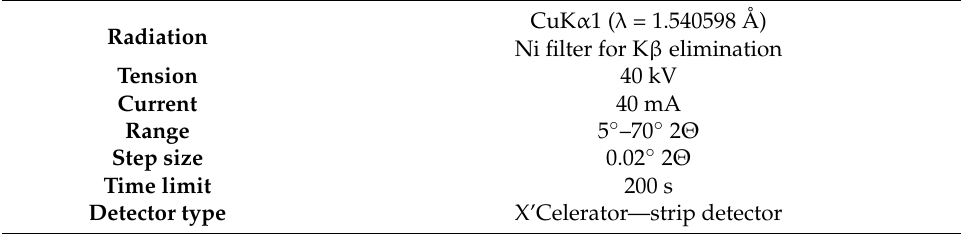
Table 3. Powder diffraction analysis